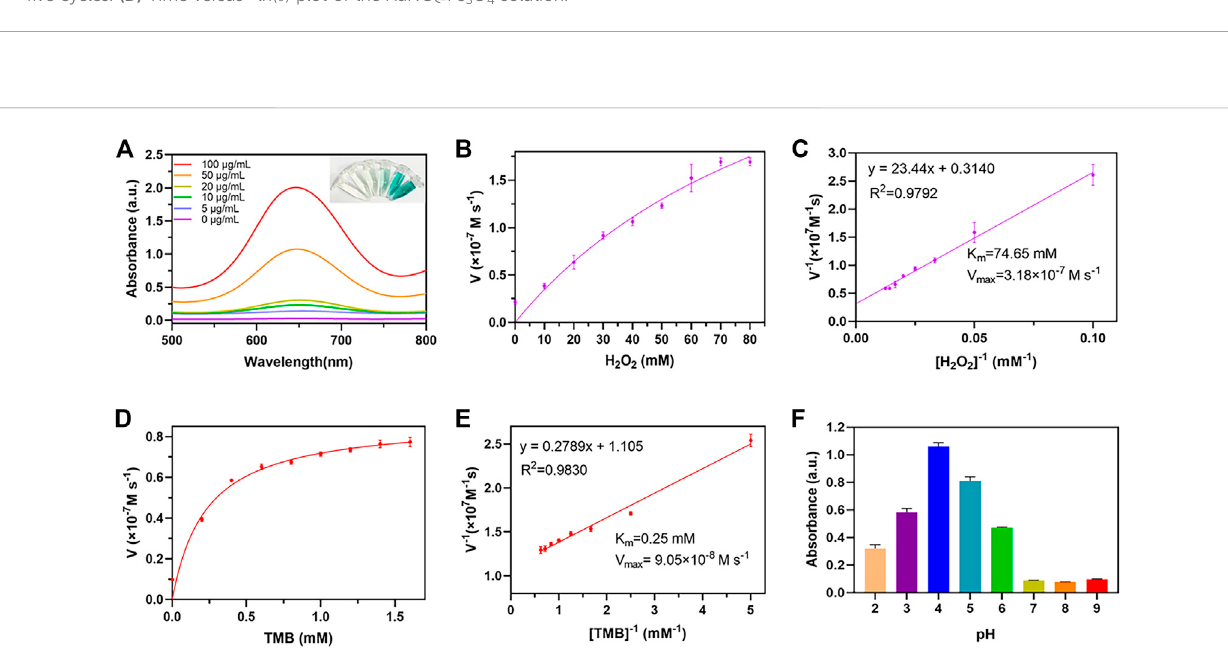
FIGURE 3 POD-like activity assay of AuNC@Fe 3 O 4 . (A) Ultraviolet-visible (UV-vis) absorption spectra of the reaction system with different concentrations. (B)